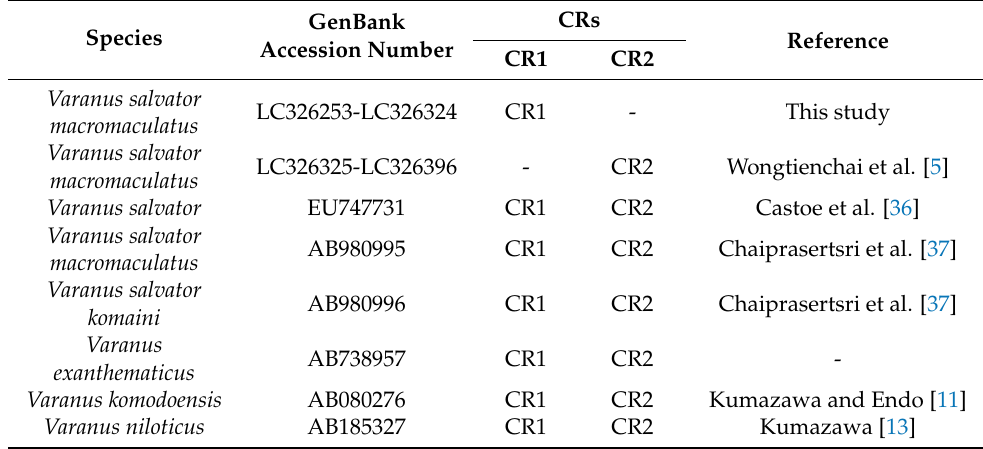
Table 1. Species used with accession